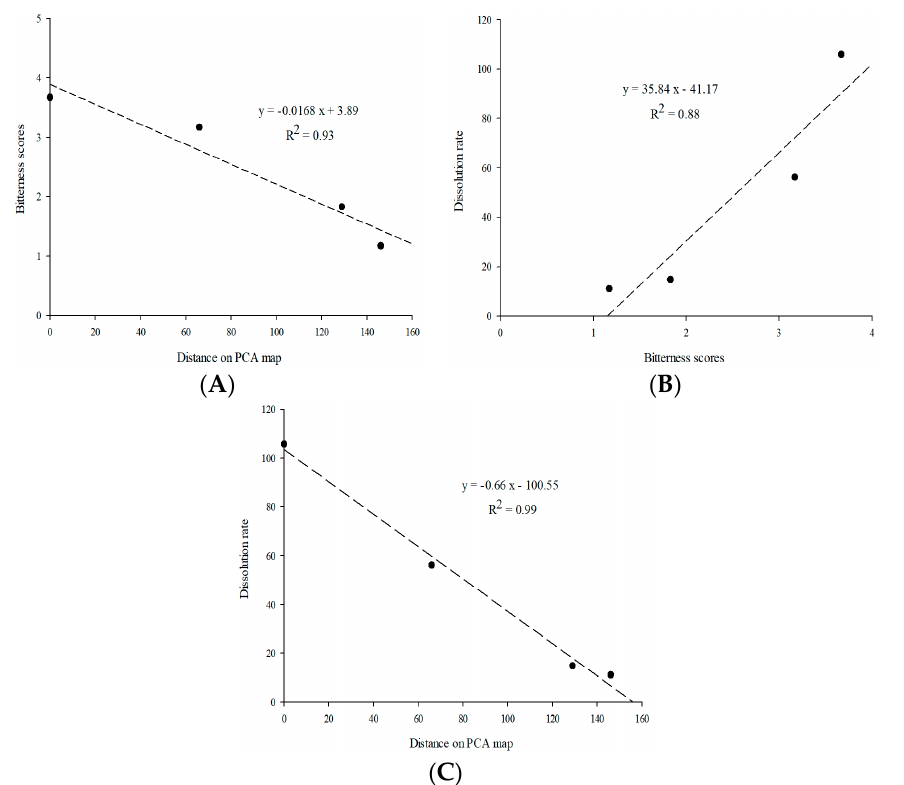
Figure 7. Correlation between results of taste-masking effectiveness. ( A ) correlation between e-tongue test and human taste panel; ( B ) correlation between human taste panel and dissolution profiles at 30 min; and ( C ) correlation between e-tongue test and dissolution profiles at 30 min.